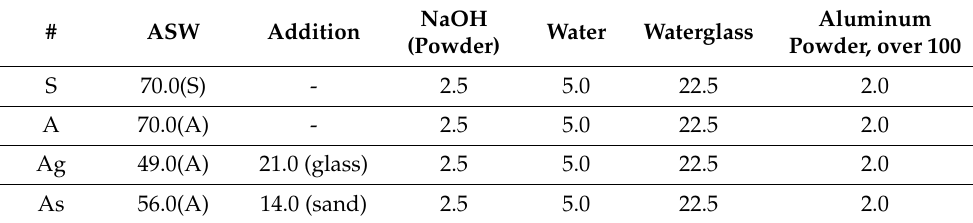
Table 2. Component composition of the geopolymer precursor, wt.%.